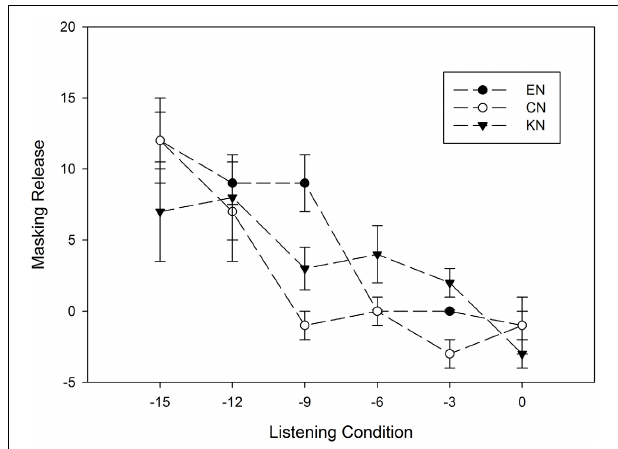
FIGURE 3 | The amount of masking release and standard errors as a function of SNRs for EN, CN and KN groups. The masking release represents the difference between vowel identification score in MTB noise and those in steady-state noise (LTSSN). A positive masking release means better performance in MTB than in steady-state